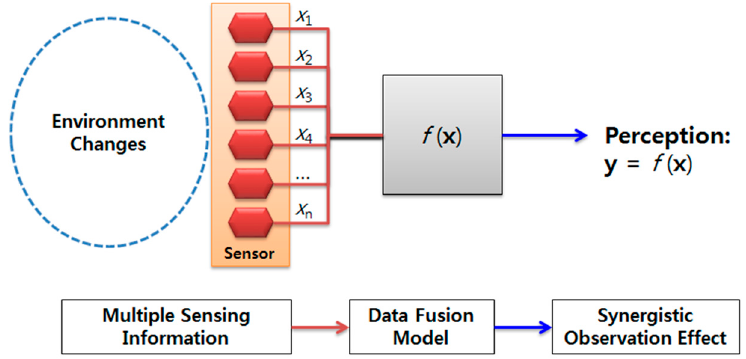
Figure 1. A multi-sensor system.